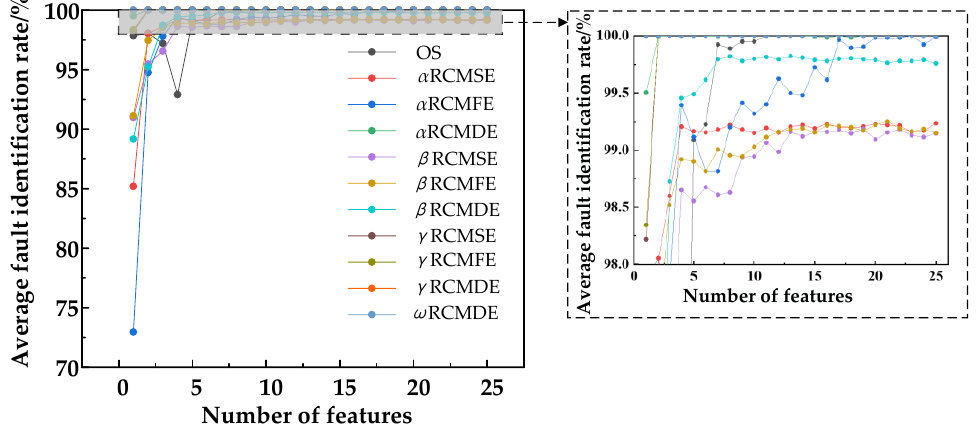
Figure 17. Bearing fault identification rate under different number of features.